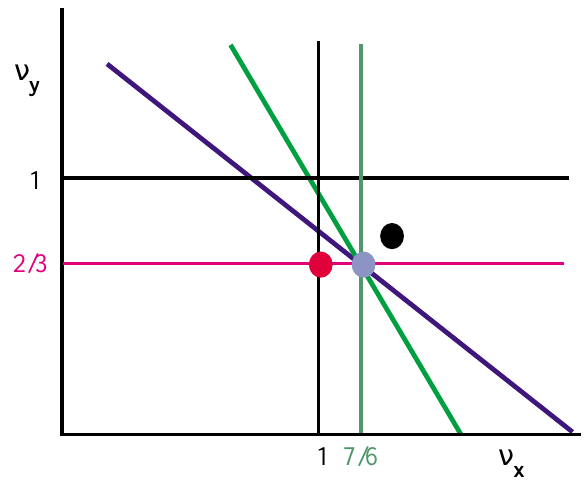
FIG. 4. (Color) Resonance lines in tune space.